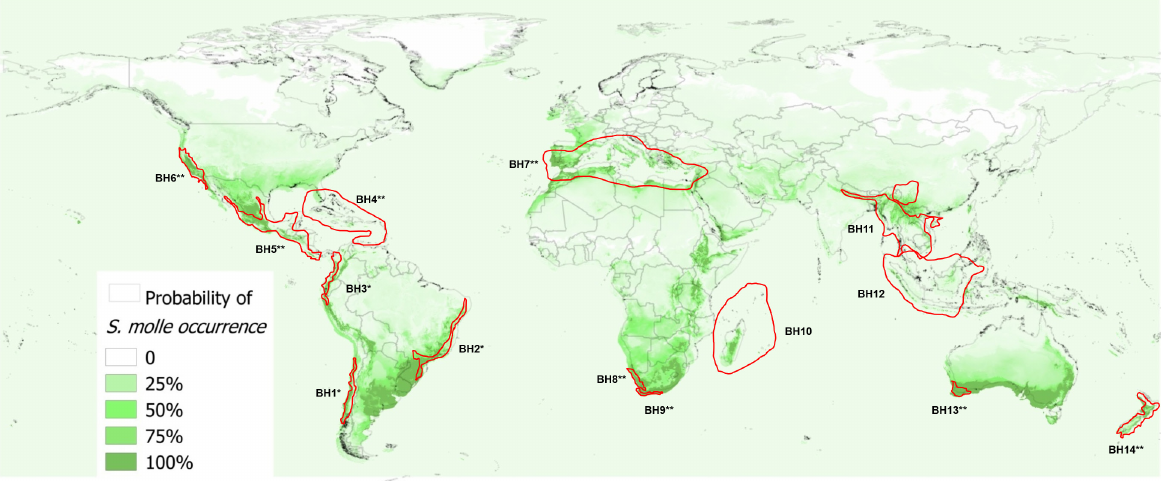
Figure 1 - Current ecological niche modeling map for Schinus molle . Highlighted areas are the 14 biodiversity hotspots (BH; Myers et al. 2000) that are susceptible to S. molle expansion. *Biodiversity Hotspots where S. molle is native. **Biodiversity Hotspots where S. molle invasion is already reported. BH1: Central Chile; BH2: Atlantic Forest; BH3: Chocó/Darlén/Western ecuador; BH4: Caribbean Islands; BH5: Mesoamerica; BH6: California Floristic Province; BH7: Mediterranean Basin; BH8: Succulent Karoo; BH9: Cape Floristic Province; BH10: Madagascar; BH11: South-Central China; BH12: Sundaland; BH13: